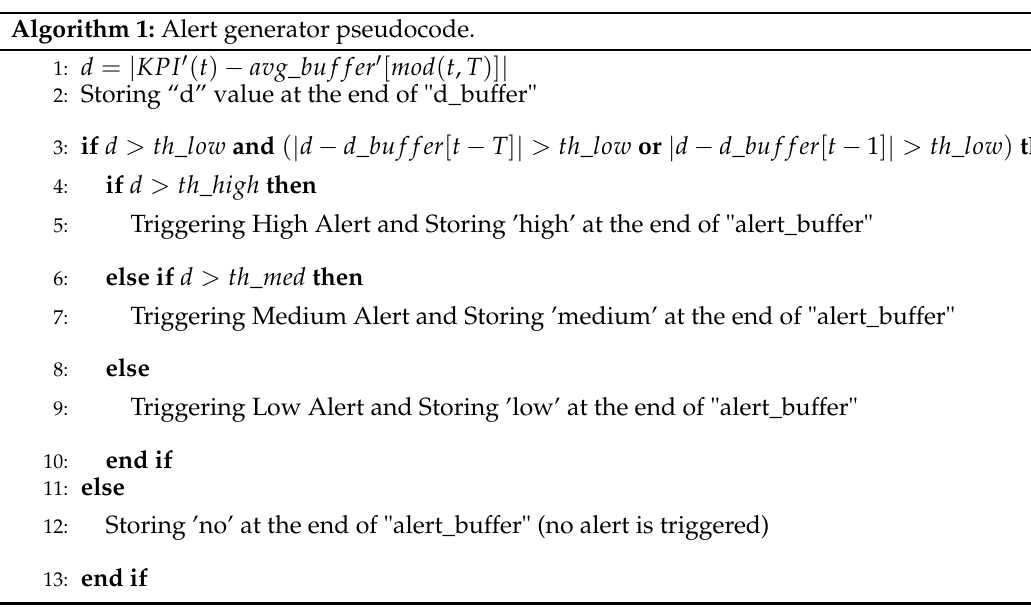
Algorithm 1: Alert generator